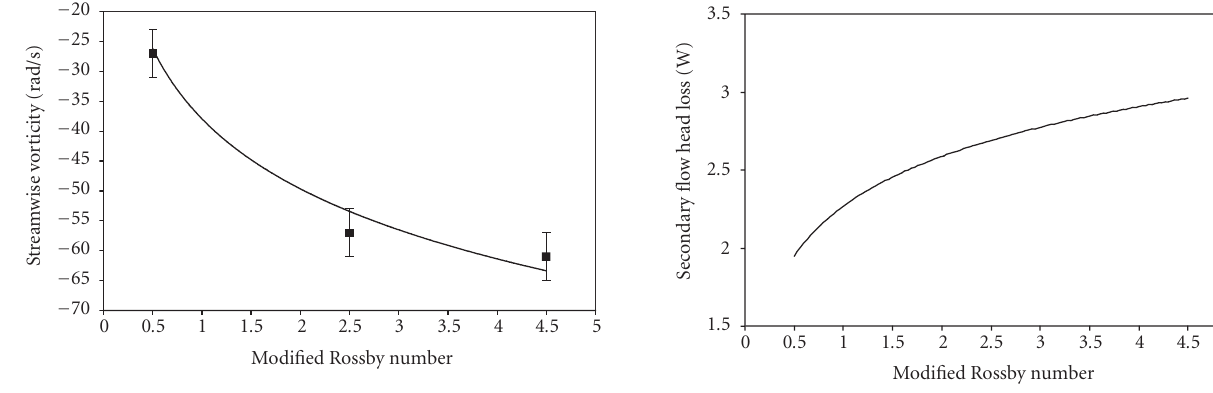
Figure 3: Streamwise vorticity as a function of modified Rossby number.